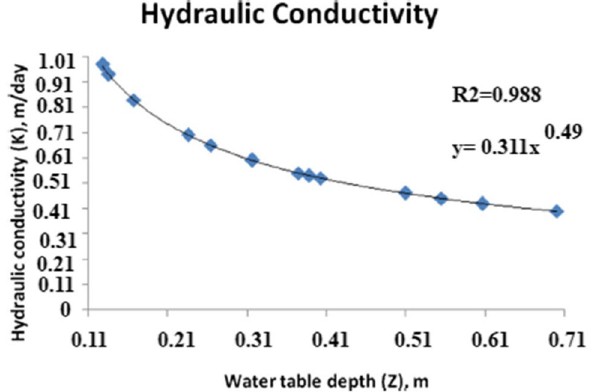
Fig. 2 Difference of hydraulic conductivity with water table penetra-